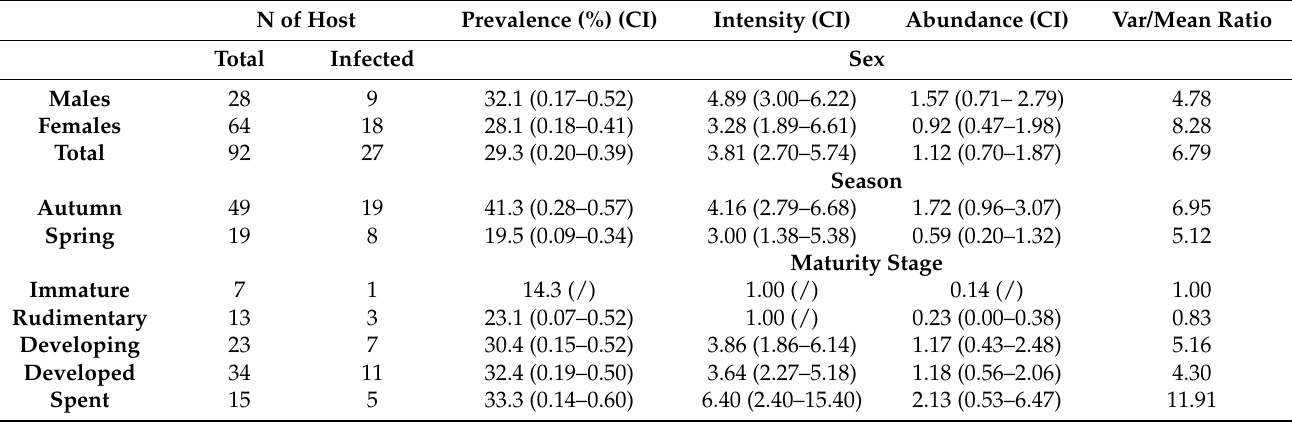
Table 6. Total mean prevalence (%) with Stern’s exact 95% confidence limits (CI), mean intensity and mean abundances with bootstrap 95% confidence limits (CI) and variance to mean ratio of serpulid polychaete colonizing Calappa granulata exoskeleton from the central eastern Adriatic